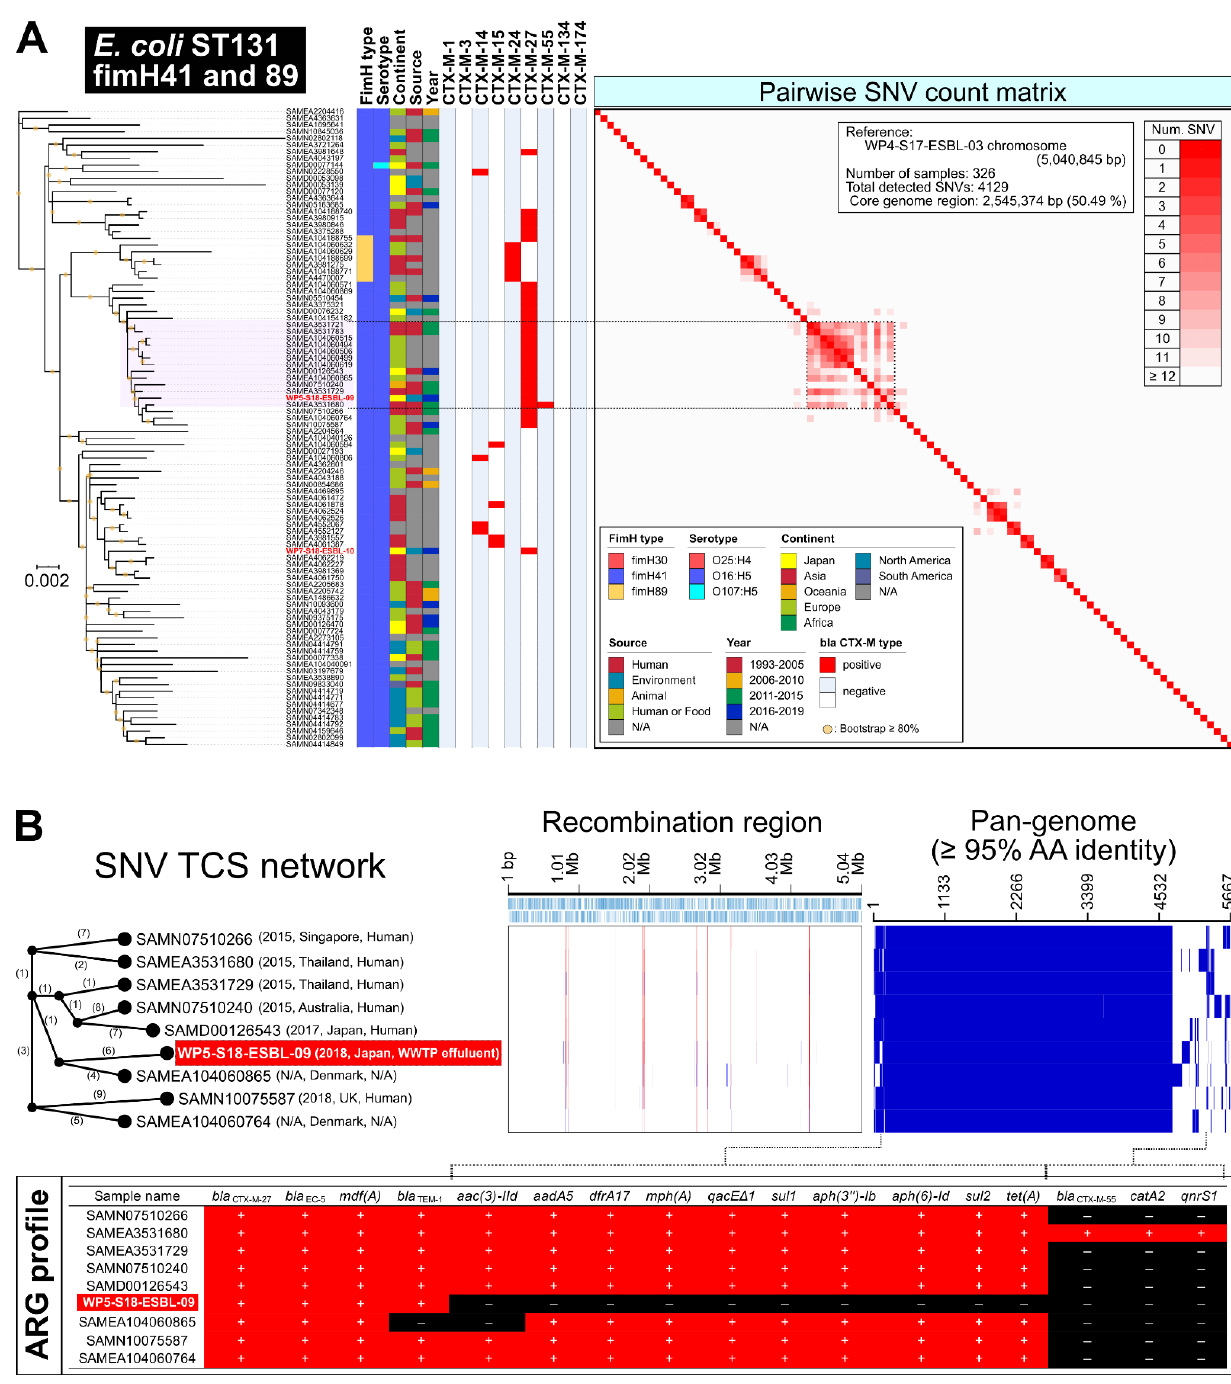
Figure 3. Characterization of E. coli O16:H5-ST131 isolates from WWTP effluents. ( A ) Highlight image for E. coli O16:H5-ST131- fimH41 with bla CTX-M-27 from Figure 2. ( B ) Core genome SNV network, genome recombination, and pan-genome analysis of clonal O16:H5-ST131- fimH41 with bla CTX-M-27 strains. Isolates in this study were highlighted by red in the strain name (see detail in Tables S2 and S3). 2.3. Other E. coli ST Isolates E. coli ST38 ( n = 10 isolates), ST10 ( n = 5 isolates), ST602 ( n = 5 isolates), ST405 ( n = 4 isolates), ST69 ( n = 3 isolates), and ST648 ( n = 3 isolates) were also detected in this study